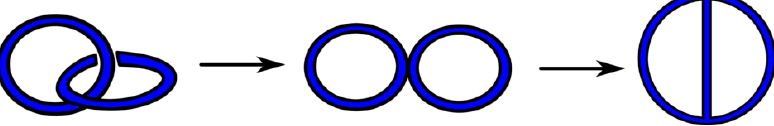
Figure 14 . A transition of the charge con(cid:12)guration which results in a transition between a non- chiral and a chiral spectrum. Starting from a TCS con(cid:12)guration of charges deforming the con(cid:12)gu- ration to one that results in a chiral